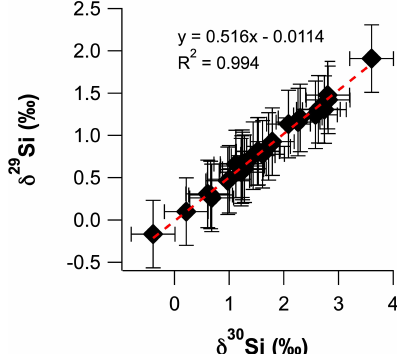
Figure A1. Linear plot of δ 29 Si as a function of δ 30 Si for all groundwater samples.